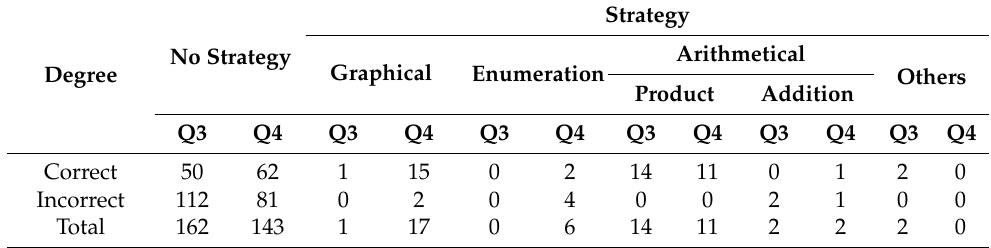
Table 7. Degree-strategy frequencies of Q3 and Q4.